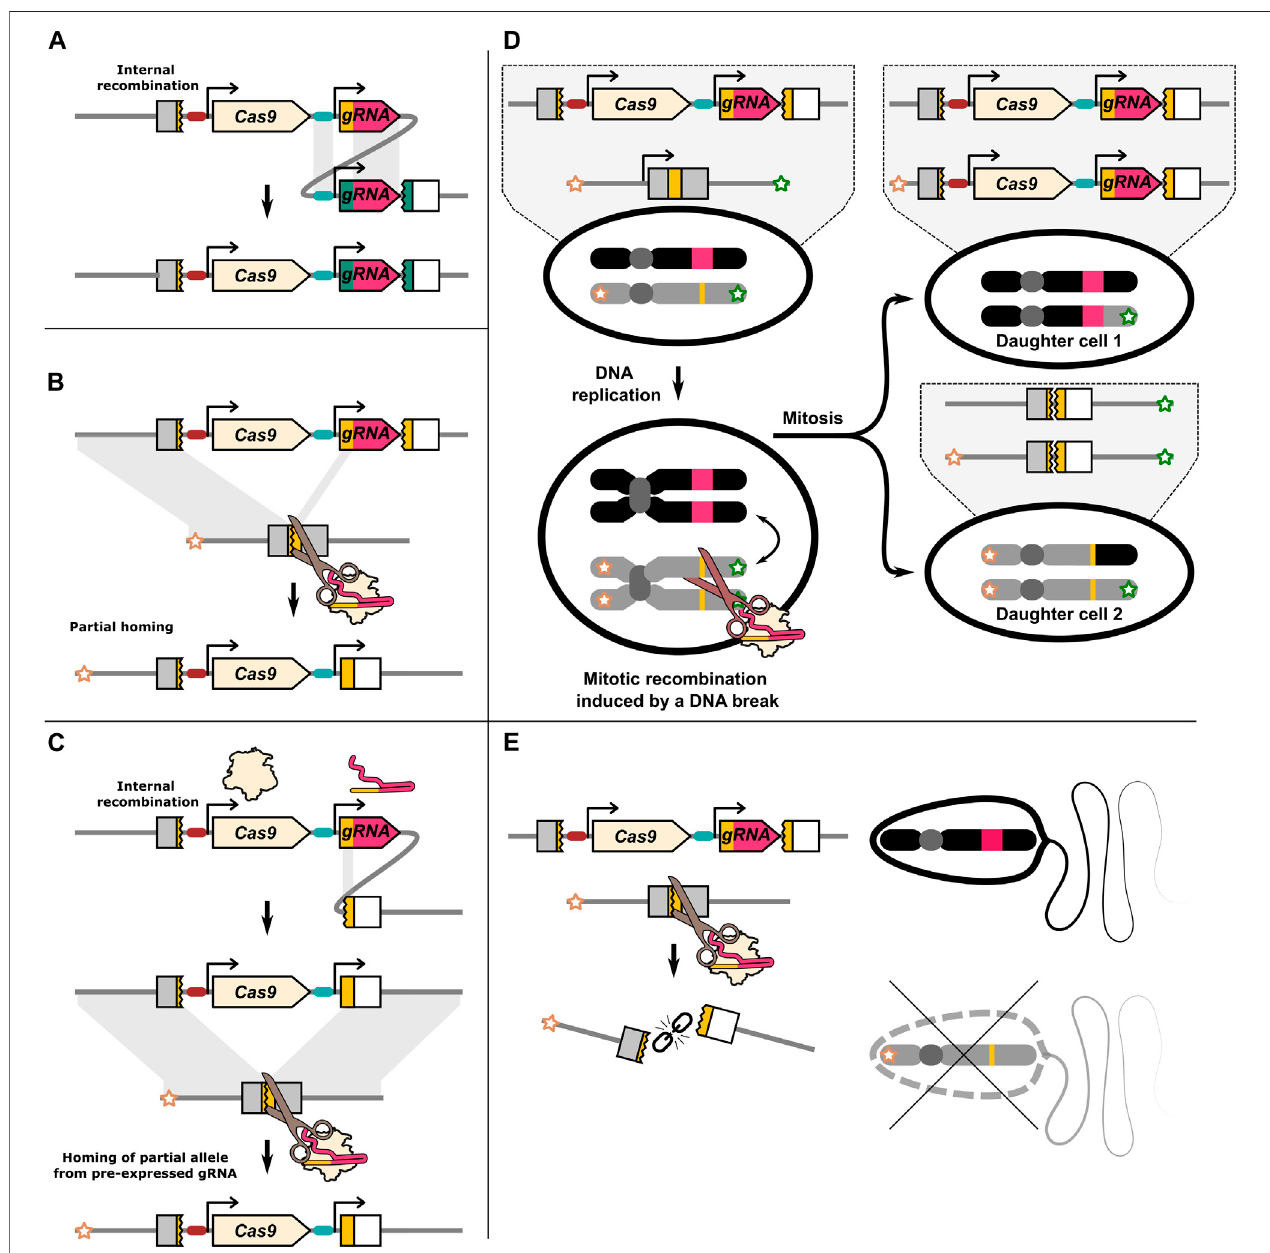
FIGURE 2 | Illustration of DNA repair outcomes that may be associated with a HEG. (A) Repetitive sequences within the HEG may lead to internal recombination. ThegRNA promoterandtheconstantgRNA “ backbone ” sequenceinmultiplexingdrives maybeparticularly susceptibletointernalrecombination. (B) Partialhomingby means of the gRNA target sequence located on the drive allele. The gRNA gene contains sequence homology to its target. This may allow for partial homing. (C) RecombinationofthegRNAtargetsequencewithapartialtargetsequenceadjacenttothedriveelement.Iftheresultingallelehomesitmayresembletheproductof partial homing even if a chromosome marker is present. (D) Cas9 induced DNA breaks have been reported to lead to mitotic recombination. This can produce two daughter cells that have loss of heterozygosity. Daughter cells generated by mitotic recombination can under some circumstances resemble products of homing. (E) In some cases a DNA break can lead to the loss of the target/recipient chromosome. This can result in inheritance bias through meiotic